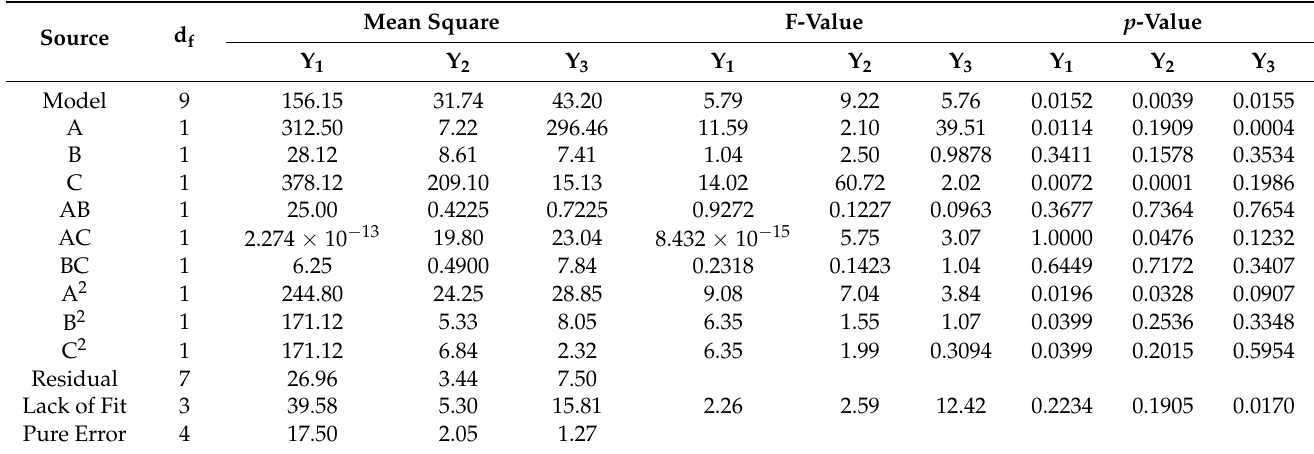
Table 9. Analysis of variance of simulation equation.